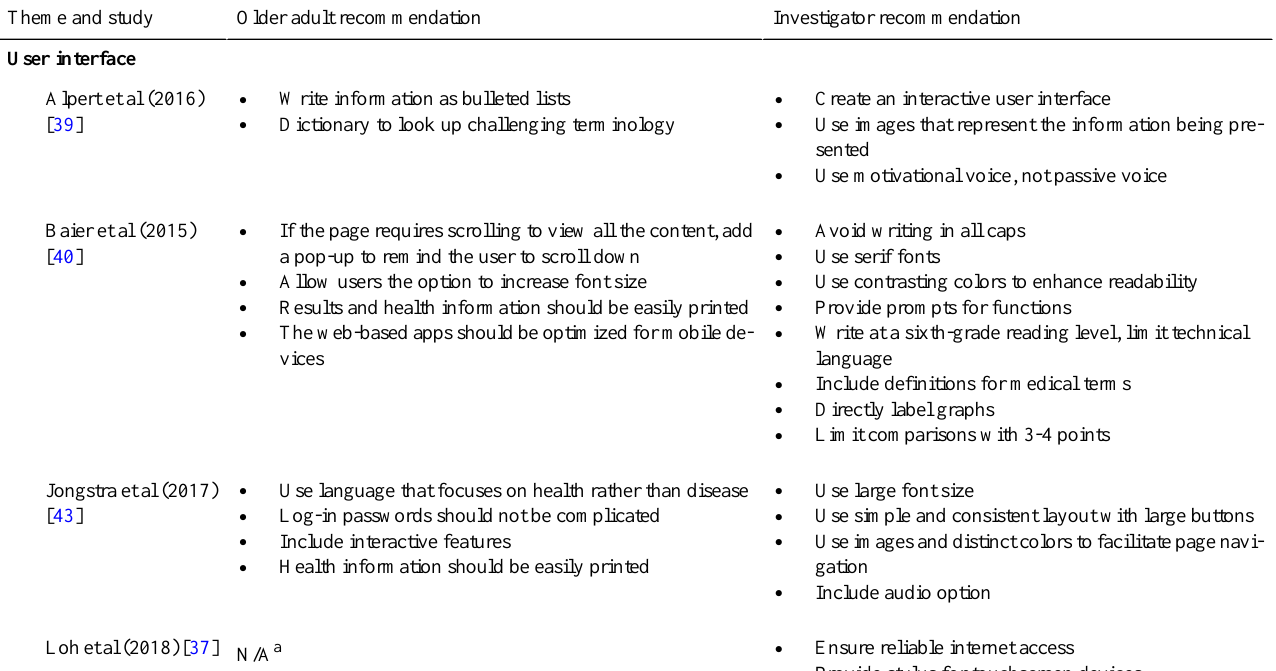
Table 3. Older adult and investigator recommendations for eHealth